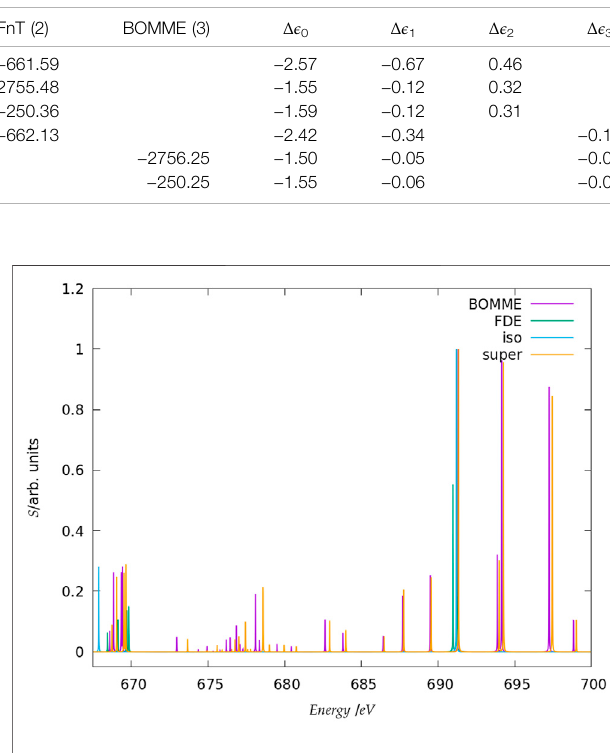
FIGURE 2 | Simulated K-edge spectra for the fl uoride model system, over the roughly 30 eV interval starting at the free ion edge peak. It should be noted that here the peak heights (in arbitrary units) for each family of models: free ion (=iso), FDE, BOMME, and supermolecule (super) have been scaled, with a height of 1 assigned to the most intense